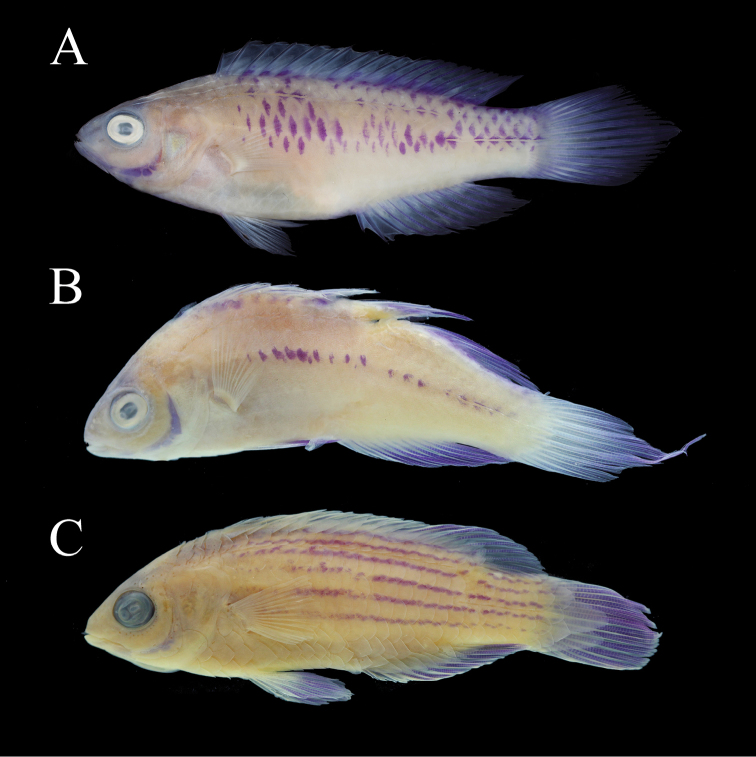
A selection of Cirrhilabrus species in preservation showing the purple staining qualities. Not to scale ACirrhilabruswakanda sp. nov., 70.3 mm SL, male holotype, CAS 246395 BCirrhilabrusblatteus, 65.1 mm SL, male, CAS 235080 CCirrhilabrusearlei, 56.5 mm SL, male paratype, CAS 213114. Photographs by L.A. Rocha (A) and B.W. Frable (B, C).